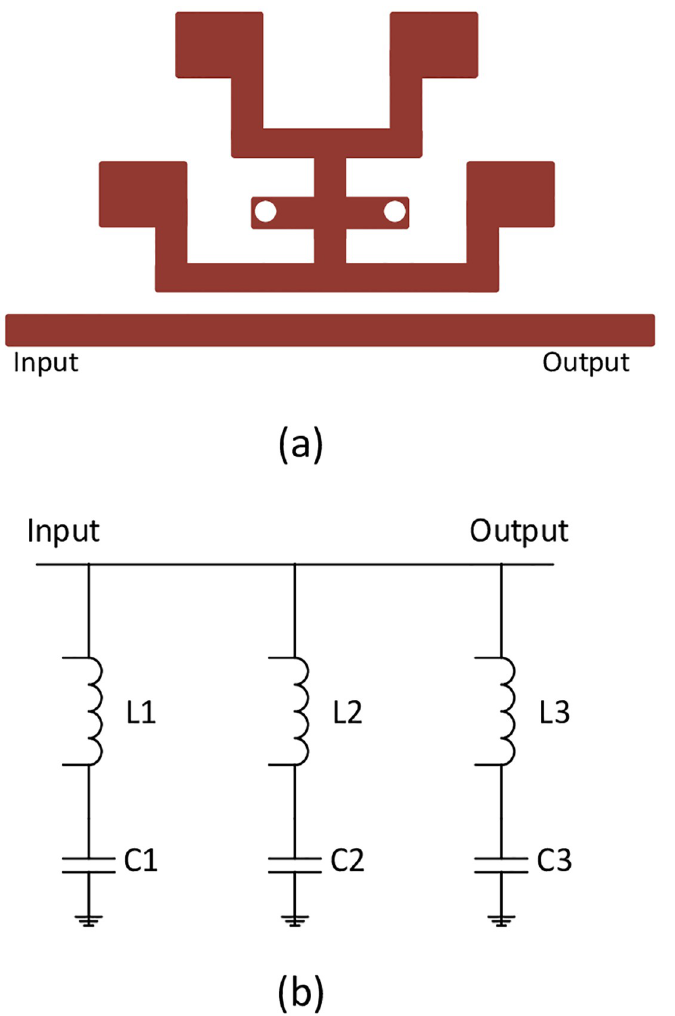
Fig 1. (a) Geometry of the TSIR (b) Equivalent transmission line